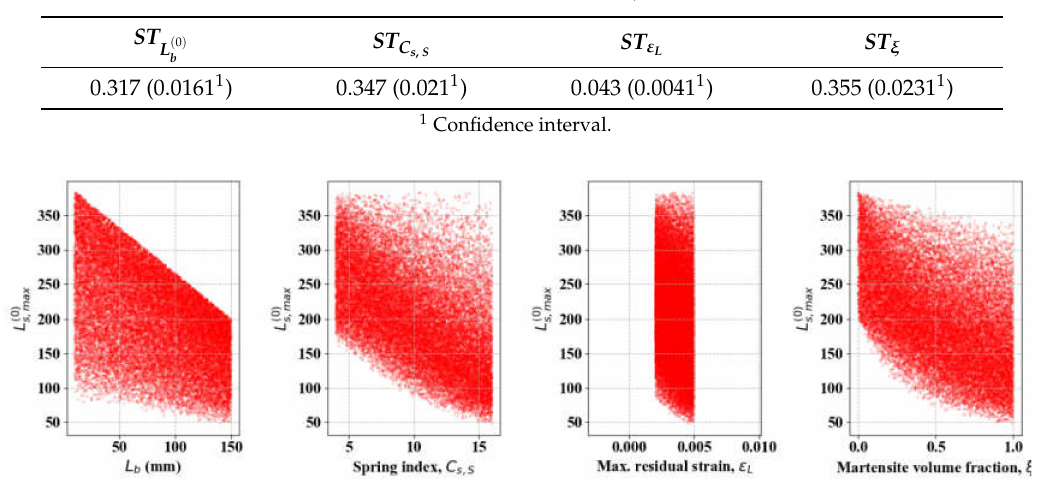
Table 3. Total Sobol indices ( ST ) of L